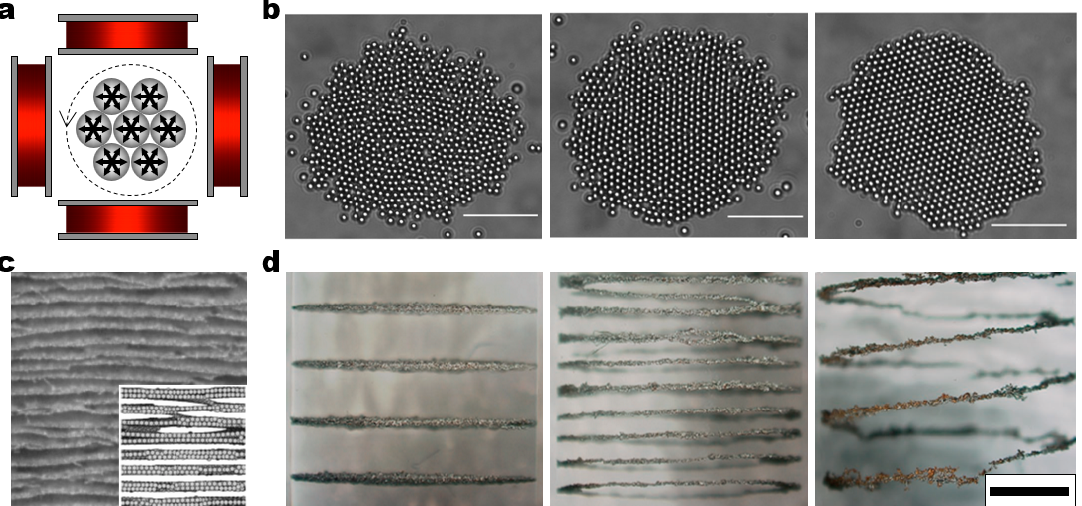
Figure 9. Field-driven dynamic structuring in a high-frequency rotating magnetic field. ( a ) Schematic of the experimental setup for a biaxial rotating magnetic field. Upon application of the field, dispersed particles self-assemble as a result of time-averaged isotropic dipolar interactions. ( b ) The phase behavior of assembled structures of 1.1 µ m carboxyl-coated paramagnetic particles depending on the field amplitude: (left) disordered fluid-like phase at the field amplitude of 8.5 Gauss, (middle) quasi-crystalline phase at the field amplitude of 9 Gauss, and (right) ordered crystal phase at the field amplitude of 11 Gauss. Scale bars: 10 µ m. Reproduced with permission [68]. Copyright 2018, American Physical Society. ( c ) Assembly of 4 µ m Fe particles into 3D multi-layered parallel sheet structures. The inset shows the corresponding simulation result. Reproduced with permission [60]. Copyright 2000, American Physical Society. ( d ) Assembly of 80 µm Fe particles into (left) 3D multi-layered parallel plates, (middle) 3D multi-layered parallel rings, and (right) 3D helical coil structures. Scale bar: 2000 µm. Reproduced with permission. Copyright 2017, Wiley [70].